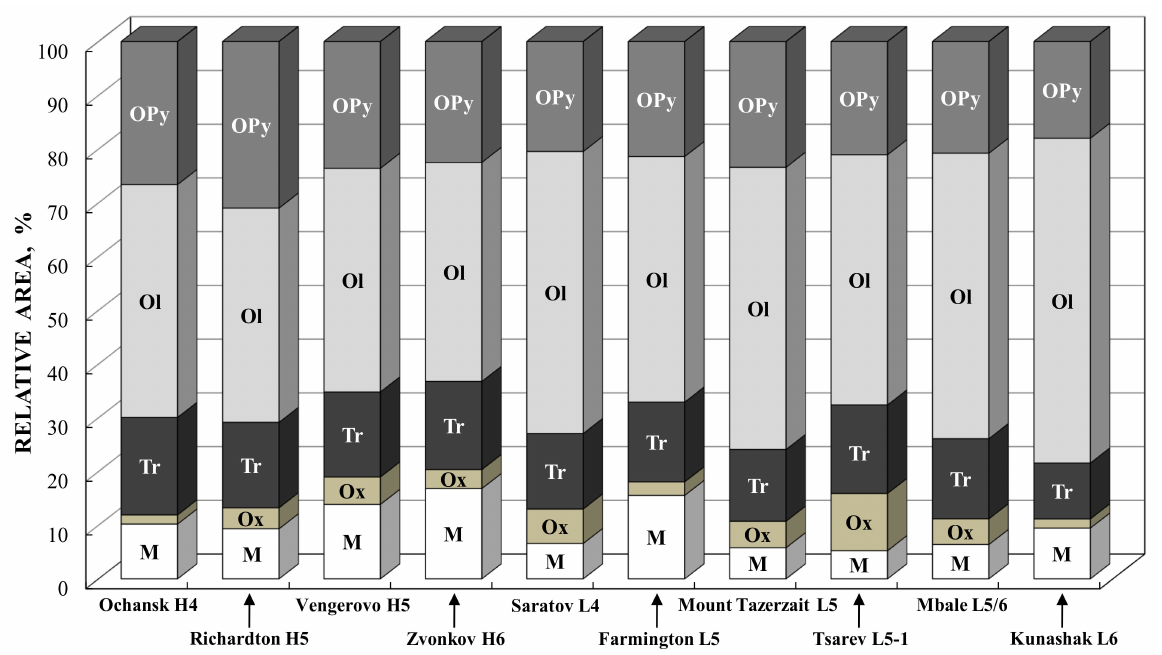
Figure 38. Modal analysis of the phase composition (the relative iron fractions) using the total relative areas of components revealed in the Mössbauer spectra of equilibrated H and L ordinary chondrites measured with a high velocity resolution. (cid:3) —the α α -Fe(Ni, Co) + γ -Fe(Ni, Co) phases ( M ), —ferric compounds ( Ox ), (cid:4) —troilite ( Tr ), —the 2 -Fe(Ni, Co) + M1 + M2 sites in olivine ( Ol ), —the M1 + M2 sites in orthopyroxene ( OPy ). Data were taken from Reference [83].